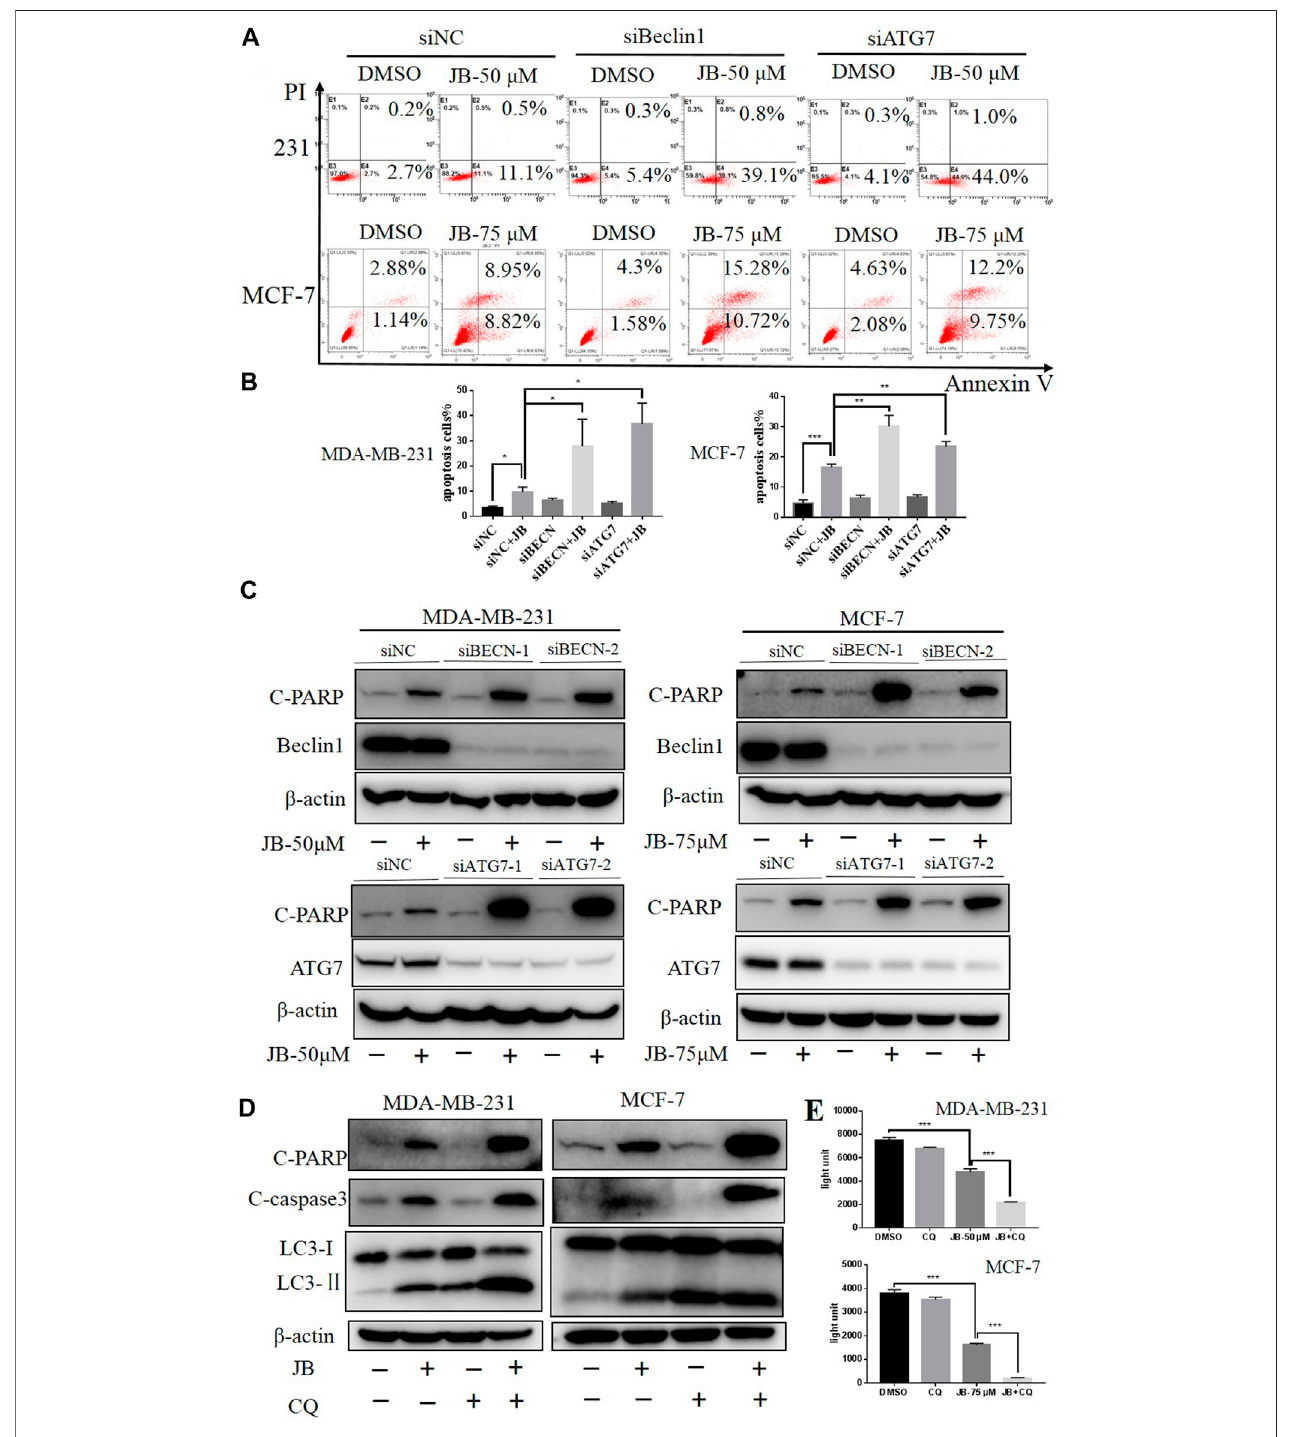
FIGURE 5 | Inhibition of JB-induced autophagy enhances apoptosis. JB-induced autophagy was inhibited via a genetic approach using siRNA of autophagy essential gene Beclin1 and ATG7, followed by treatment of JB for 48 h. Flow cytometry was performed to detect apoptosis (A) , and statistical analysis of the relative apoptotic percentages were presented by mean ± SEM (B) . The expressions of C-PARP, ATG7, and Beclin1 were detected by western blot (C) . Further, CQ was used to block autophagy;then, apoptosis characterized byC-PARP and C-cas3 wasdetermined (D) . Cell viability under thecondition ofJB and/or CQ wasdetermined by ATPlite (E) . * p < 0.05; ** p < 0.01; *** p < 0.001, n (cid:2) 3.